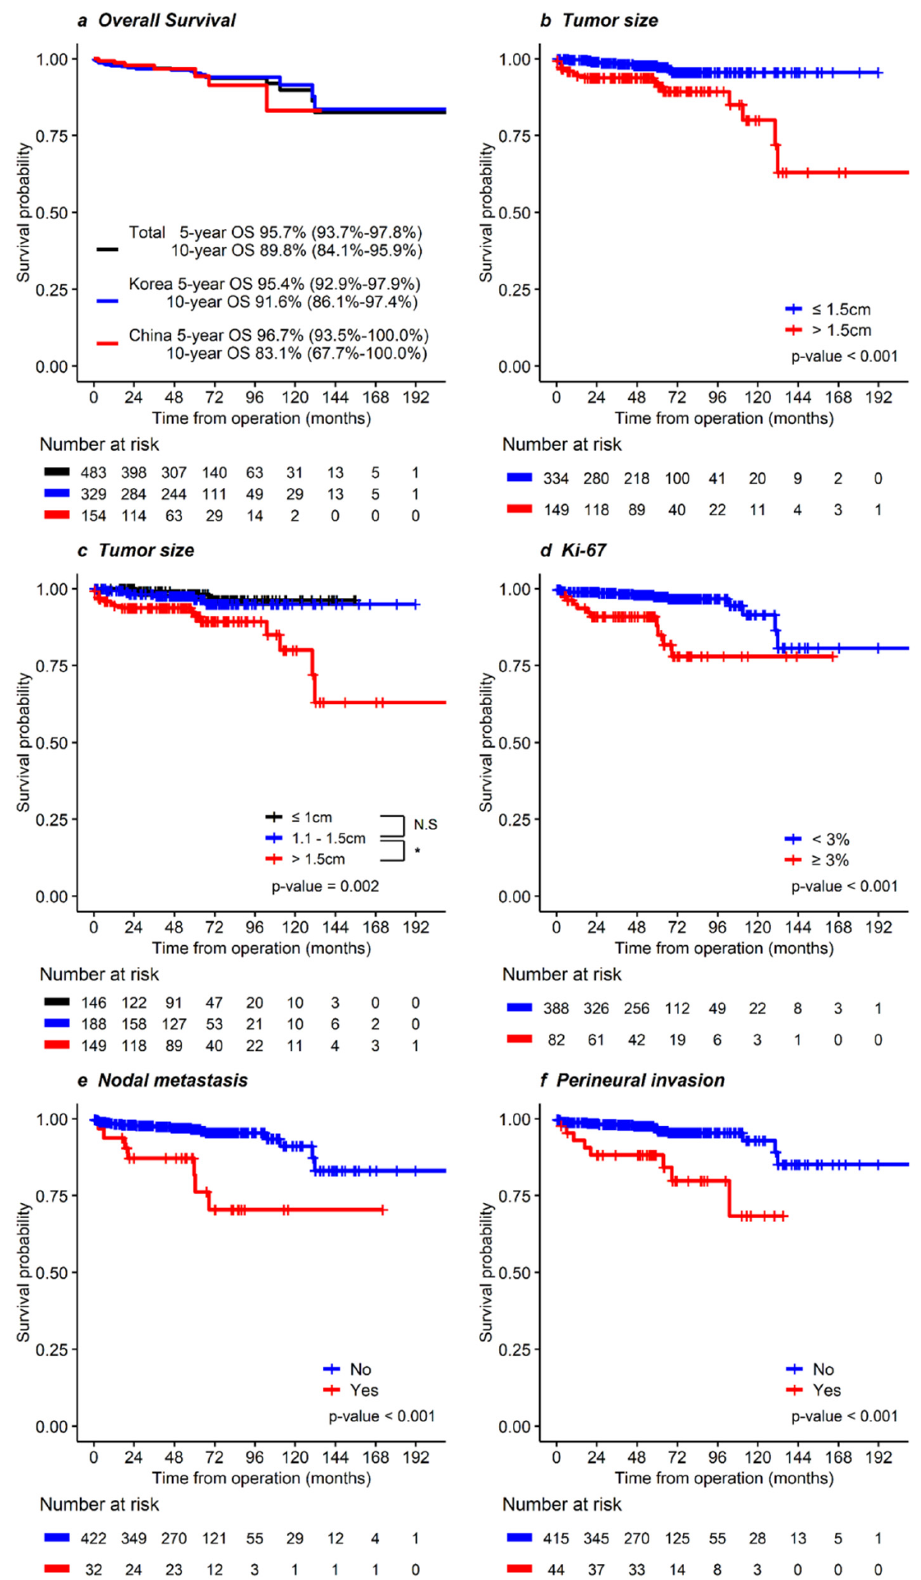
Figure 1. Kaplan-Meier curves for overall survival in patients with NF-pNETs ≤ 2 cm. In ( a ) total, Korean, and Chinese patients and according to ( b ) tumor size ≤ 1.5 or >1.5 cm, ( c ) tumor size ≤ 1, 1–1.5, or >1.5 cm, ( d ) Ki-67 index <3, or ≥ 3%, ( e ) nodal metastasis, and ( f ) perineural invasion.